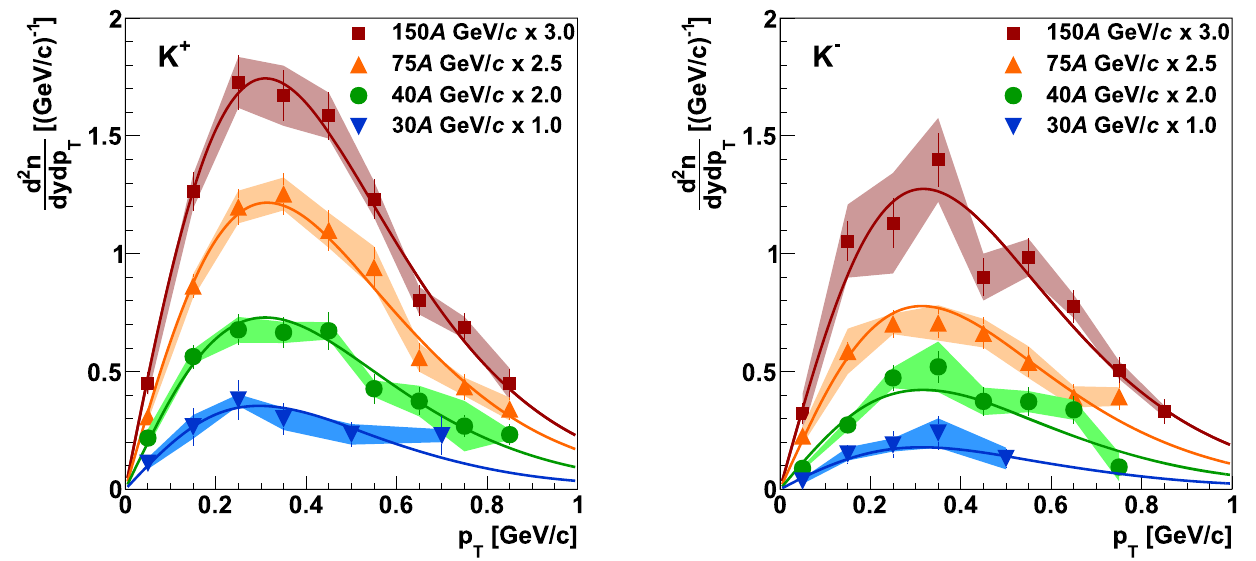
Fig. 26 Transverse momentum spectra of K + (left) and K − (right) mesons produced in 0 < y < 0 . 2 ( − 0 . 2 < y < 0 . 0 for 30 A GeV / c ) in the 20% most central Be+Be collisions. Colored lines represent the fitted function (Eq.